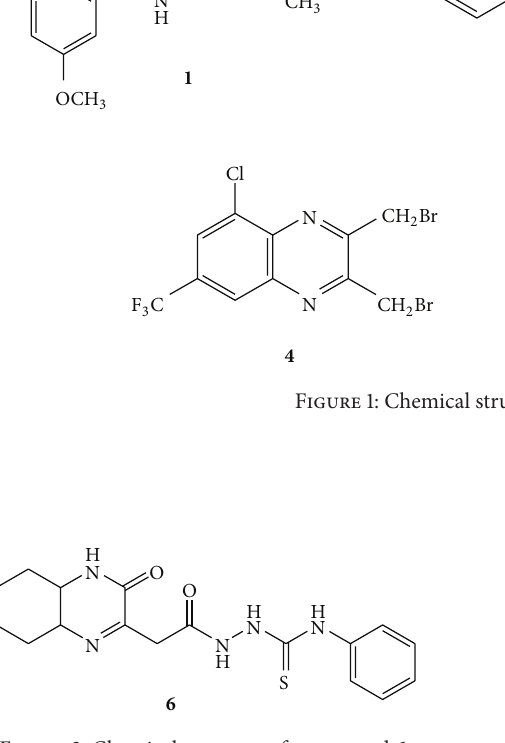
Figure 2: Chemical structure of compound 6 .